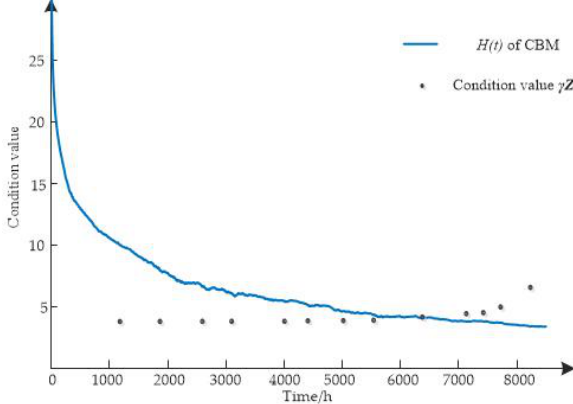
Fig. 6. Maintenance strategy of Gearbox